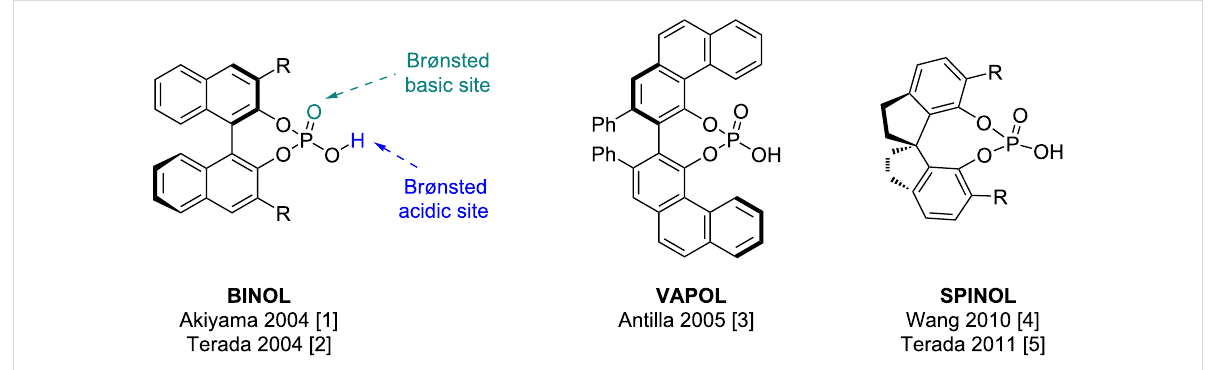
Figure 1: Chiral phosphorus acids (CPAs) derived from BINOL, VAPOL, and SPINOL. R = H, Ph, 4-PhC 6 H 4 -, 4- β -naphthylphenyl, 9-anthryl, 3,5- dimesitylphenyl, 3,5-diphenylphenyl, 4-MeC 6 H 4 -, 4-CF 3 C 6 H 4 -, 4- t -BuC 6 H 4 -, β -naphthyl, 3,5- t -Bu 2 C 6 H 3 -, 2,4,6-Me 3 C 6 H 2 -, 2,4,6-iPr 3 C 6 H 2 -, Ph 3 Si-, etc.